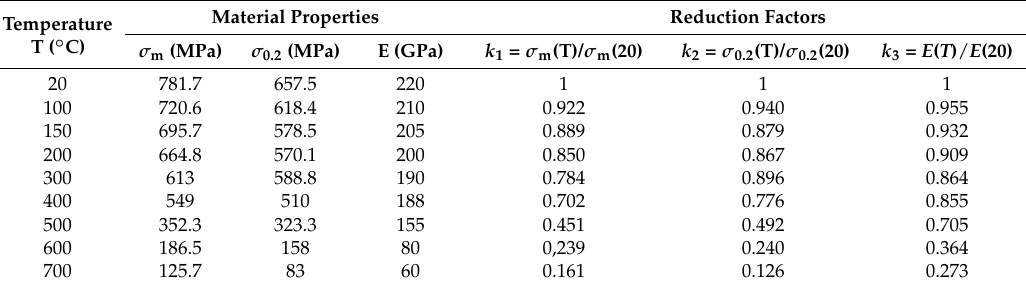
Table 2. Material properties versus temperature and reduction factors: X46Cr13 steel. ( σ m , ultimate tensile strength; σ 0.2 , 0.2 offset yield strength; E, modulus of elasticity).